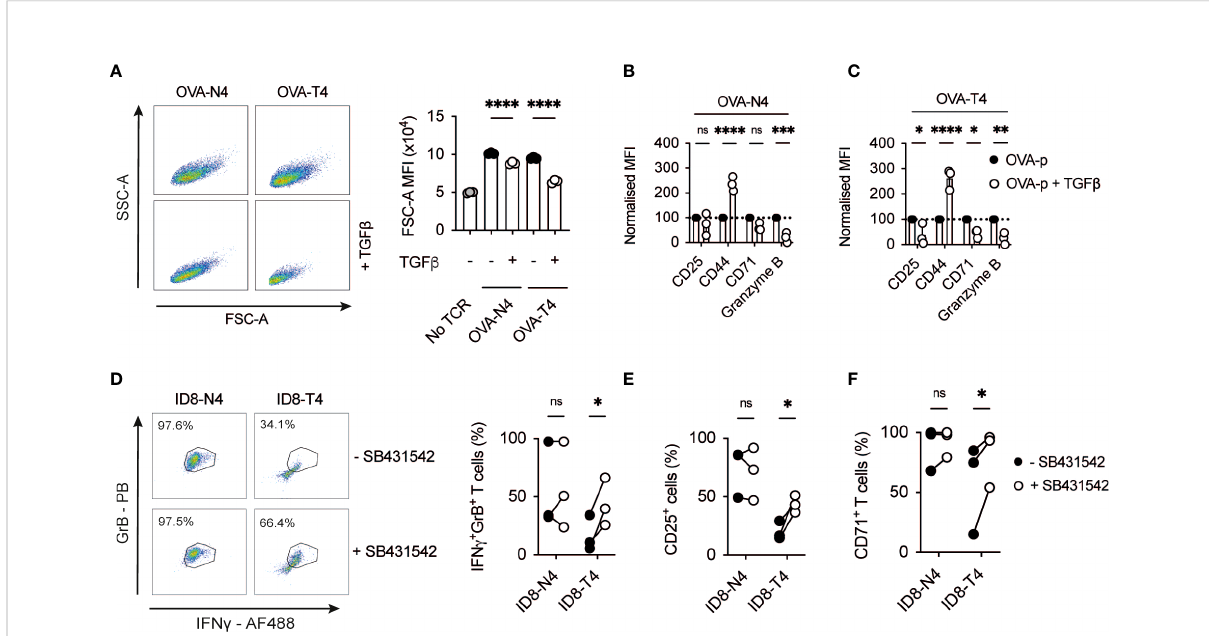
FIGURE 1 TGF b inhibits CD8 + T cell activation in response to low af fi nity antigen (A-C) OT-I T cell receptor (TCR) transgenic T cells were stimulated with cognate SIINFEKL (OVA-N4) or low af fi nity SIITFEKL (OVA-T4) peptides in the presence or absence of TGF b for 48 hours in vitro . (A) T cell growth was assessed by analysis of forward and side scatter area (FSC-A/SSC-A) by FACS. (B, C) Cell surface expression of activation markers (CD25, CD44, CD71) or intracellular granzyme B were determined by fl ow cytometry. Data shown represent mean fl uorescence intensity